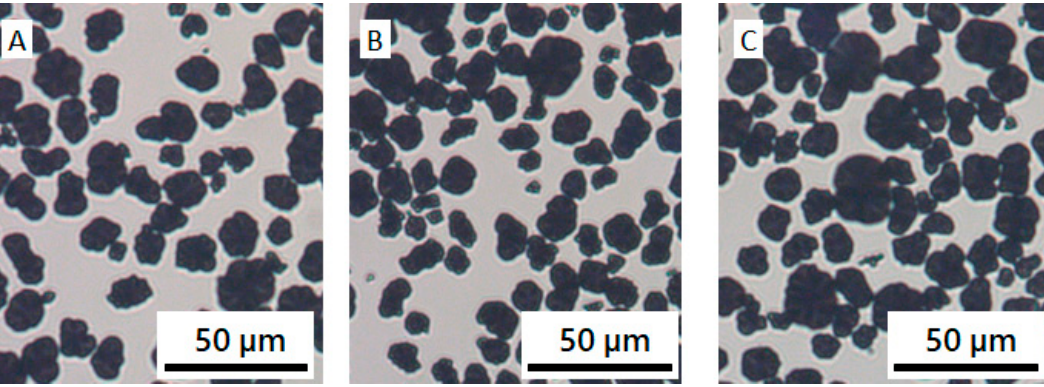
Figure 6. Microscope images of NCM particles in ( A ) NMP, ( B ) PVDF / NMP solution φ PVDF = 2.5 wt%, and ( C ) PVP / NMP solution of φ PVP = 2.5 wt%.